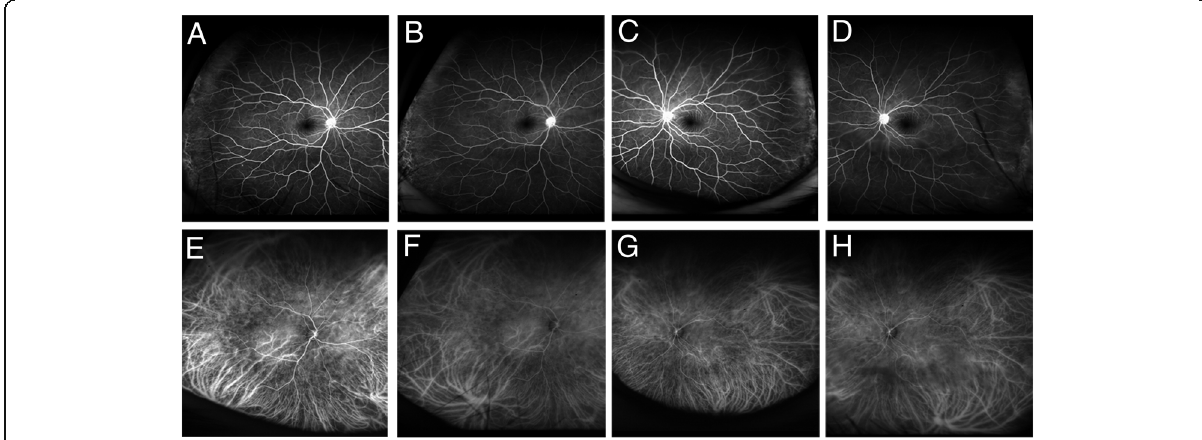
Fig. 5 Wide-field angiography findings using Optos California 7 months after the steroid tapering therapy. a – d Fluorescein angiograms. a Early phase image in the right eye. b Late phase image in the right eye. c Early phase image in the left eye. d Late phase image in the left eye. The hyperfluorescence at baseline almost resolved in both eyes. e – h Indocyanine green angiograms. e Early phase image in the right eye. f Late phase image in the right eye. g Early phase image in the left eye. h Late phase image in the left eye. The hyperfluorescence at baseline almost resolved in both eyes, but the hypofluorescent dots still remained in both